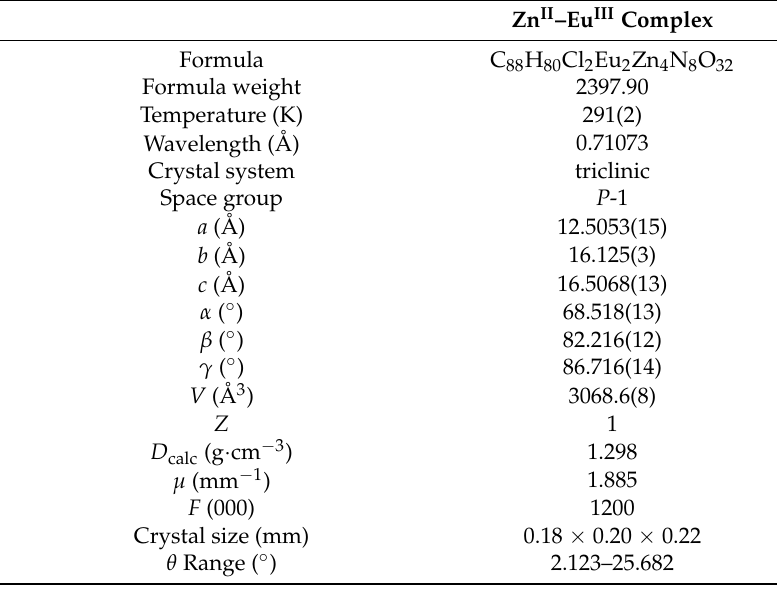
Table 1. Crystal data and refinement parameters for the Zn II –Eu III complex.